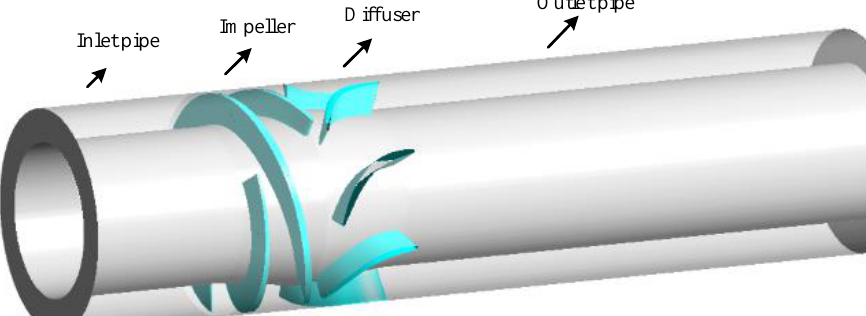
Figure 1. Numerical model.